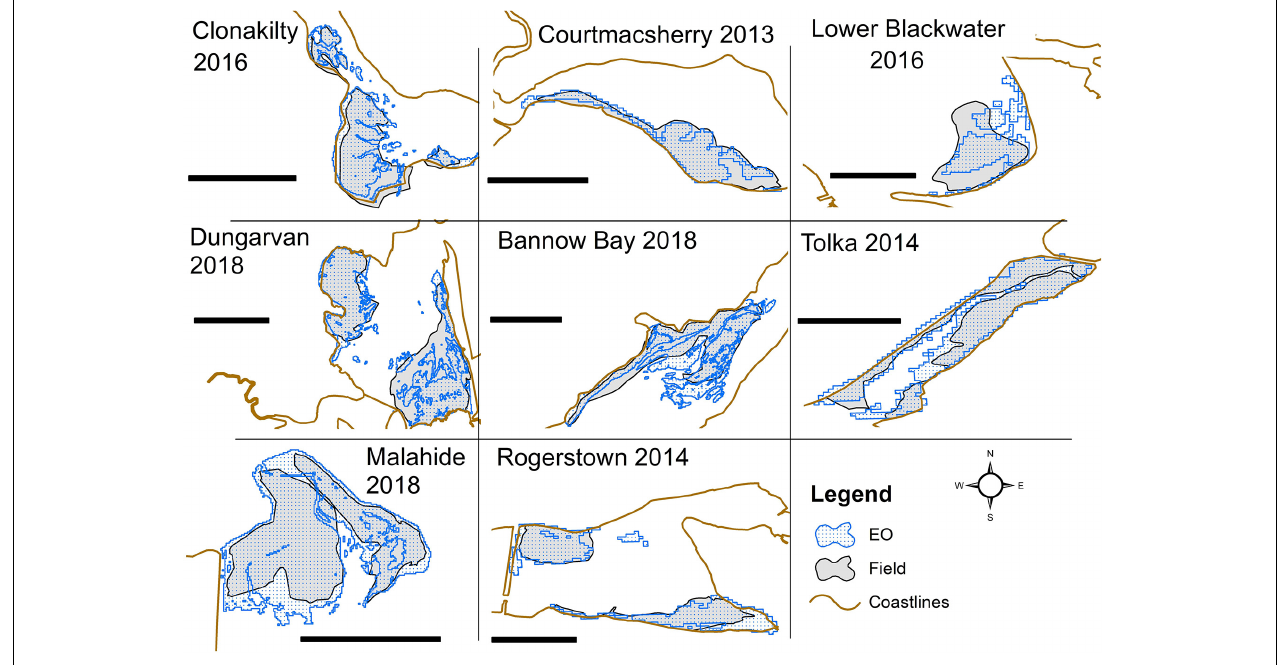
FIGURE 4 | Eight locations showing selected sites with coverages from EO and the corresponding field surveys. Scale bar shows 1 km in all the locations.